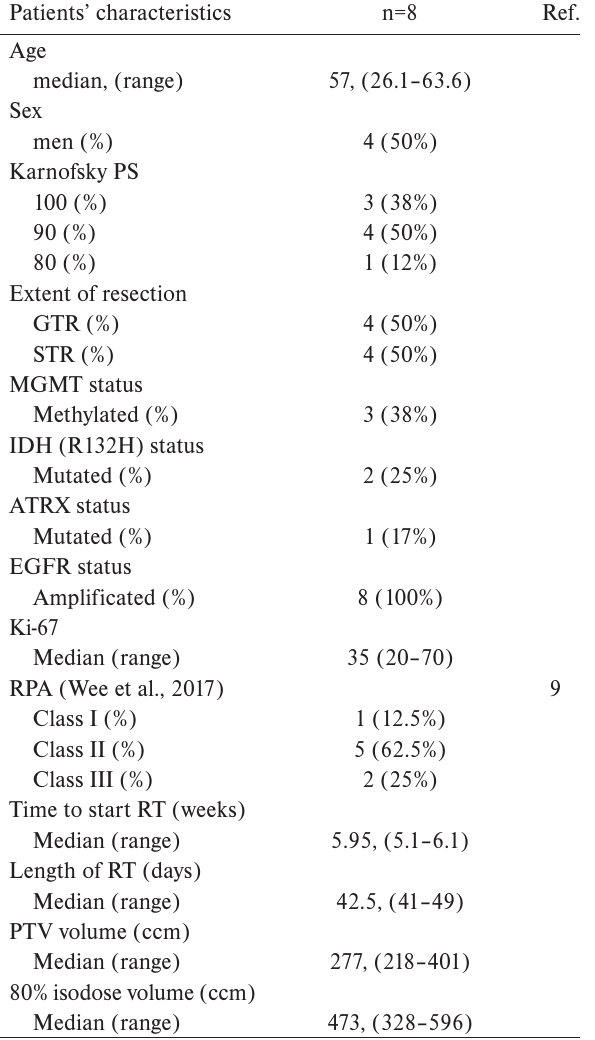
Table 1. Patients’ disease and postoperative RT characteristics.